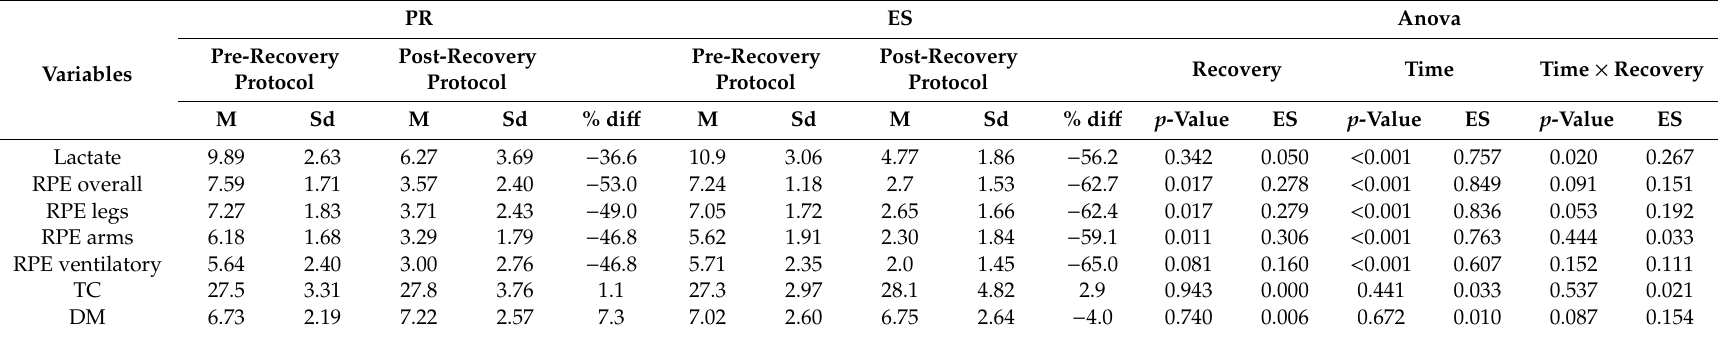
Table 2. Comparison after a water rescue, pre and post levels of blood lactate, and perceived exertion between recovery types. PR ES